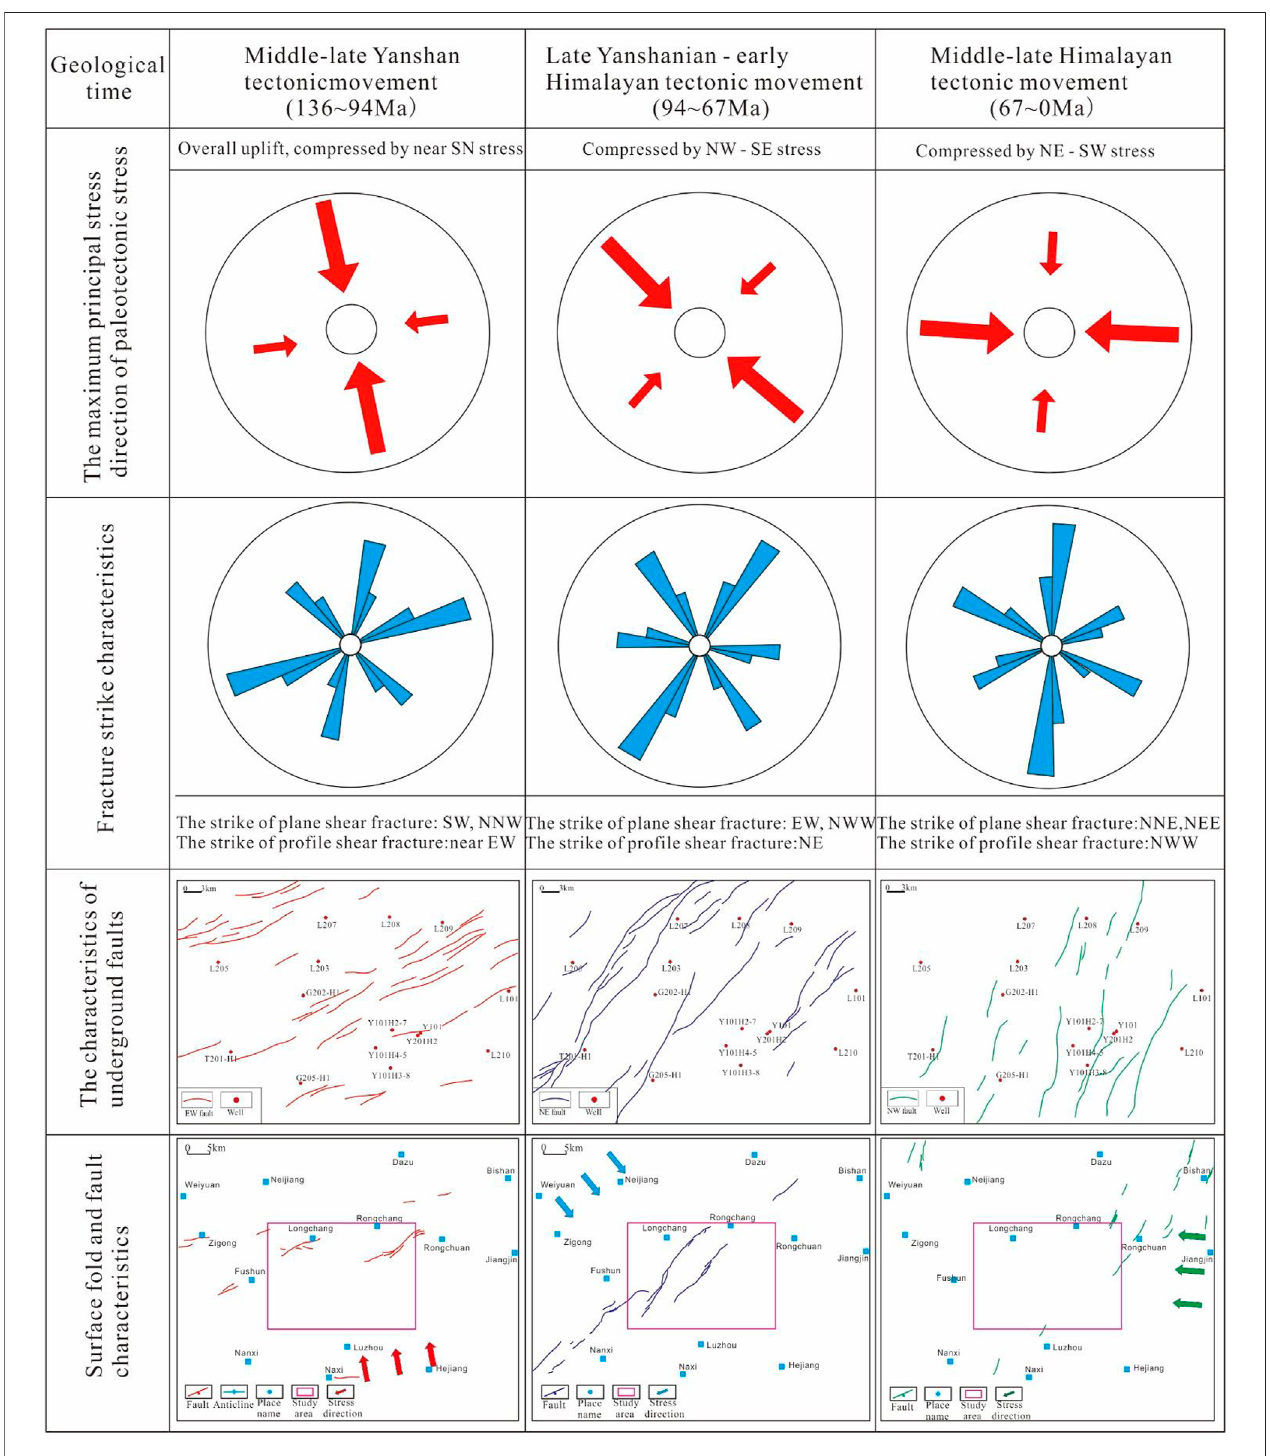
FIGURE 12 | Fracture and fault evolution model for the Longmaxi Formation of the Luzhou area.